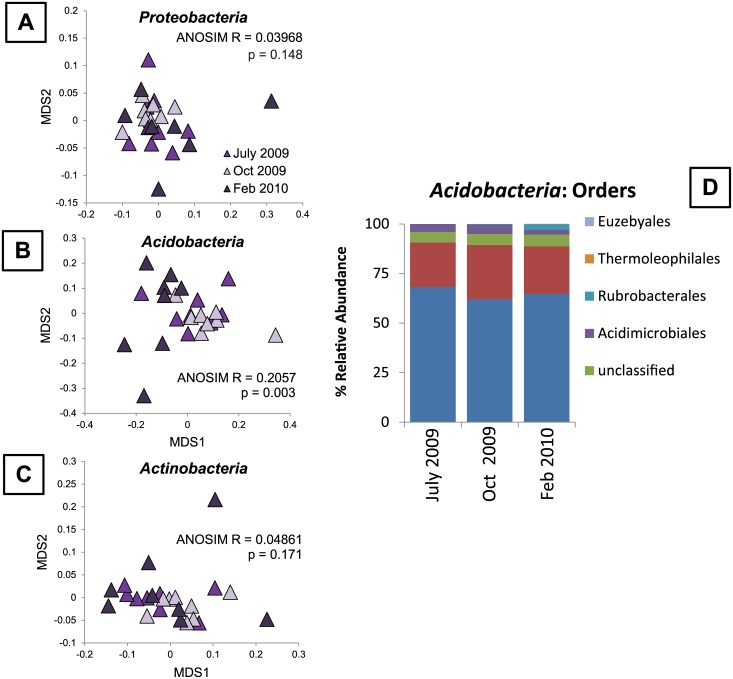
Changes in 16S rRNA-based community composition in Florida soils over time.(A) Relative abundances of all taxa classified at the phylum level and unclassified taxa over time. (B) NMDS ordination of all order-level taxa classified within the phylum Proteobacteria, which did not vary over time (ANOSIM R = 0.03968, p = 0.148). (C) NMDS ordination of all order-level taxa classified within the phylum Actinobacteria, which did not vary over time (ANOSIM R = 0.04861, p = 0.171). (D) NMDS ordination of all order level taxa classified within the phylum Acidobacteria, which varied significantly over time (ANOSIM R = 0.2057, p = 0.003).